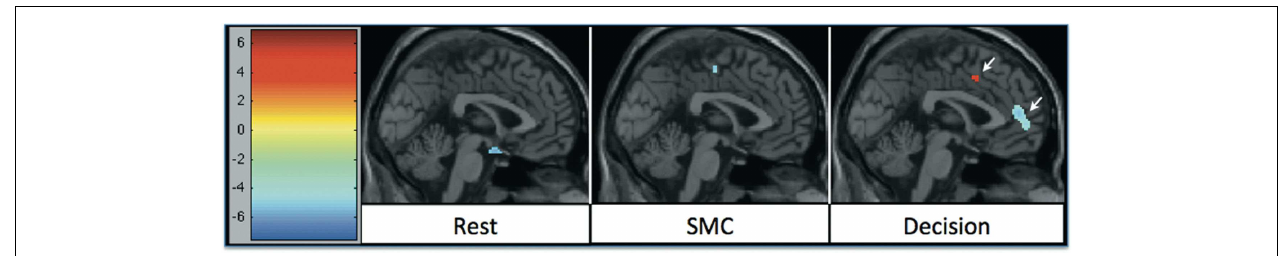
FIGURE 2 | rCBF changes relative to 1 week ofAPD treatment after 6weeks of treatment. Increases in activation are shown in red, and decreases are shown in blue.The significant decrease in activation in medial frontal areas shifted between week 1 and week 6 of treatment.The shift was most significant during the decision task condition.